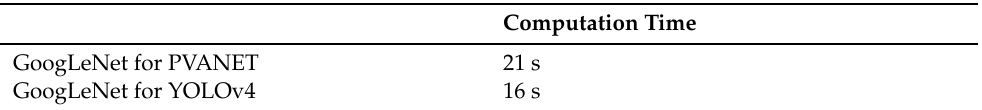
Table 4. Computation time of the recognition of GoogLeNet for all the detections of PVANET and